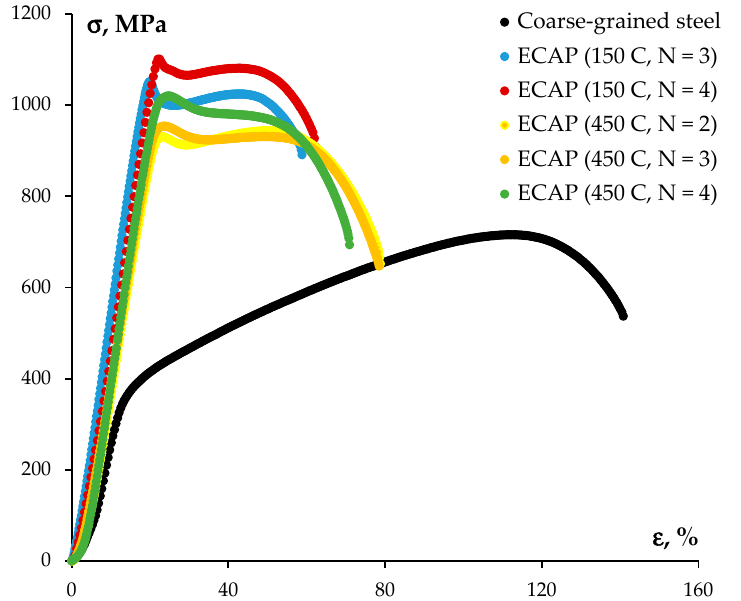
Figure 10. Stress–strain tension curves for CG and UFG steel specimens at RT. σ ( ε ) curves for UFG steels had concave shapes with upper yield strengths expressed clearly. σ ( ε ) curves for UFG steel specimens show a short stage of stable strain flow, which transforms into a strain localization stage. A rapid stress drop of 30–50 MPa was observed at initial stages of σ ( ε ) curves for UFG steels (Figure 10). The presence of ‘maxima’ with upper yield strength on σ ( ε ) curves for UFG steels can be linked to the strain aging effect [30–32] or discontinuous Lüders strain, which can also lead to shapes observed on σ ( ε ) curves [5]. An increase in ECAP temperature from 150 ◦ C to 450 ◦ C resulted in an insufficient increase in the duration of a uniform strain hardening stage (Figure 10).